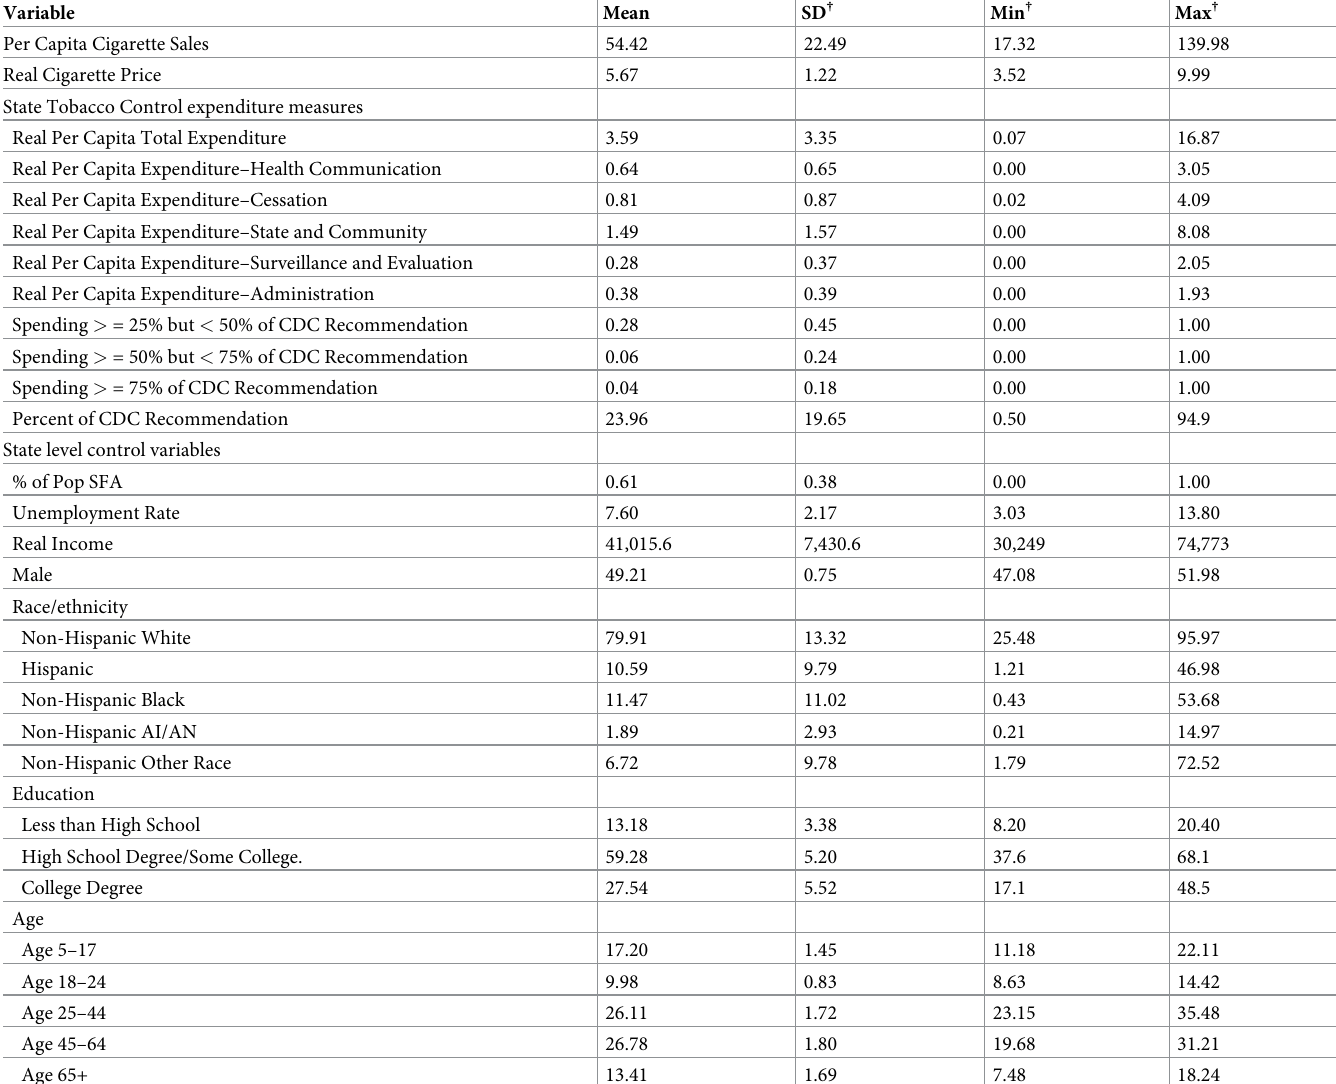
Table 1. Descriptive statistics: United States for years